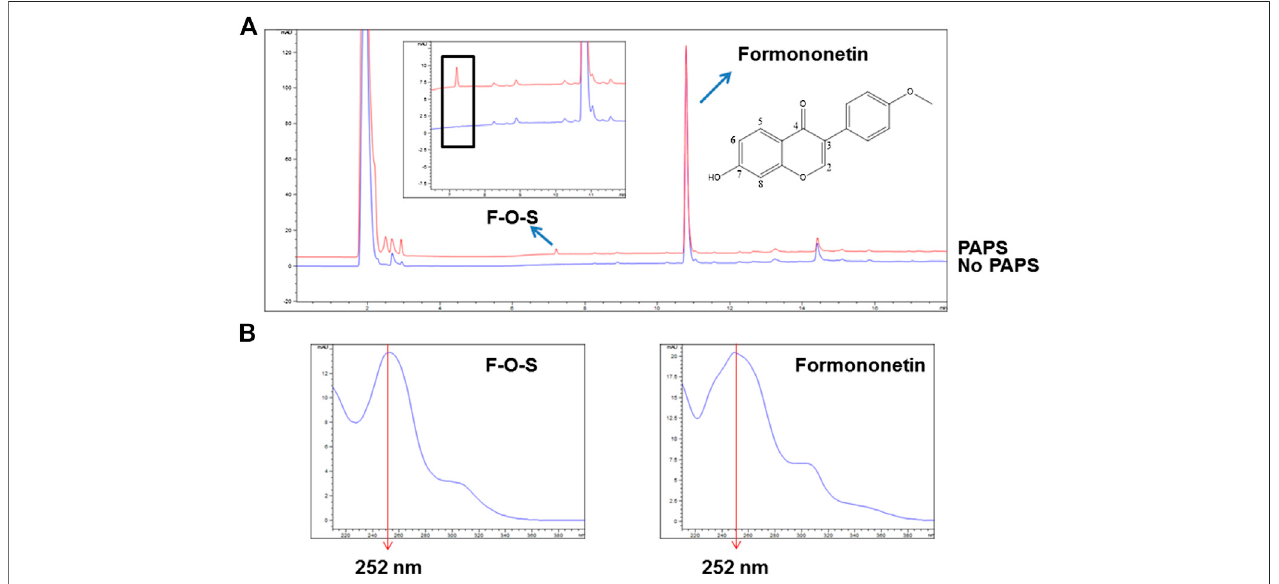
FIGURE 2 | (A) Chemical structure of formononetin and representative HPLC chromatograms for quantitative analyses of formononetin and its sulfate (F-O-S). (B) UV absorption spectra of formononetin and F-O-S.